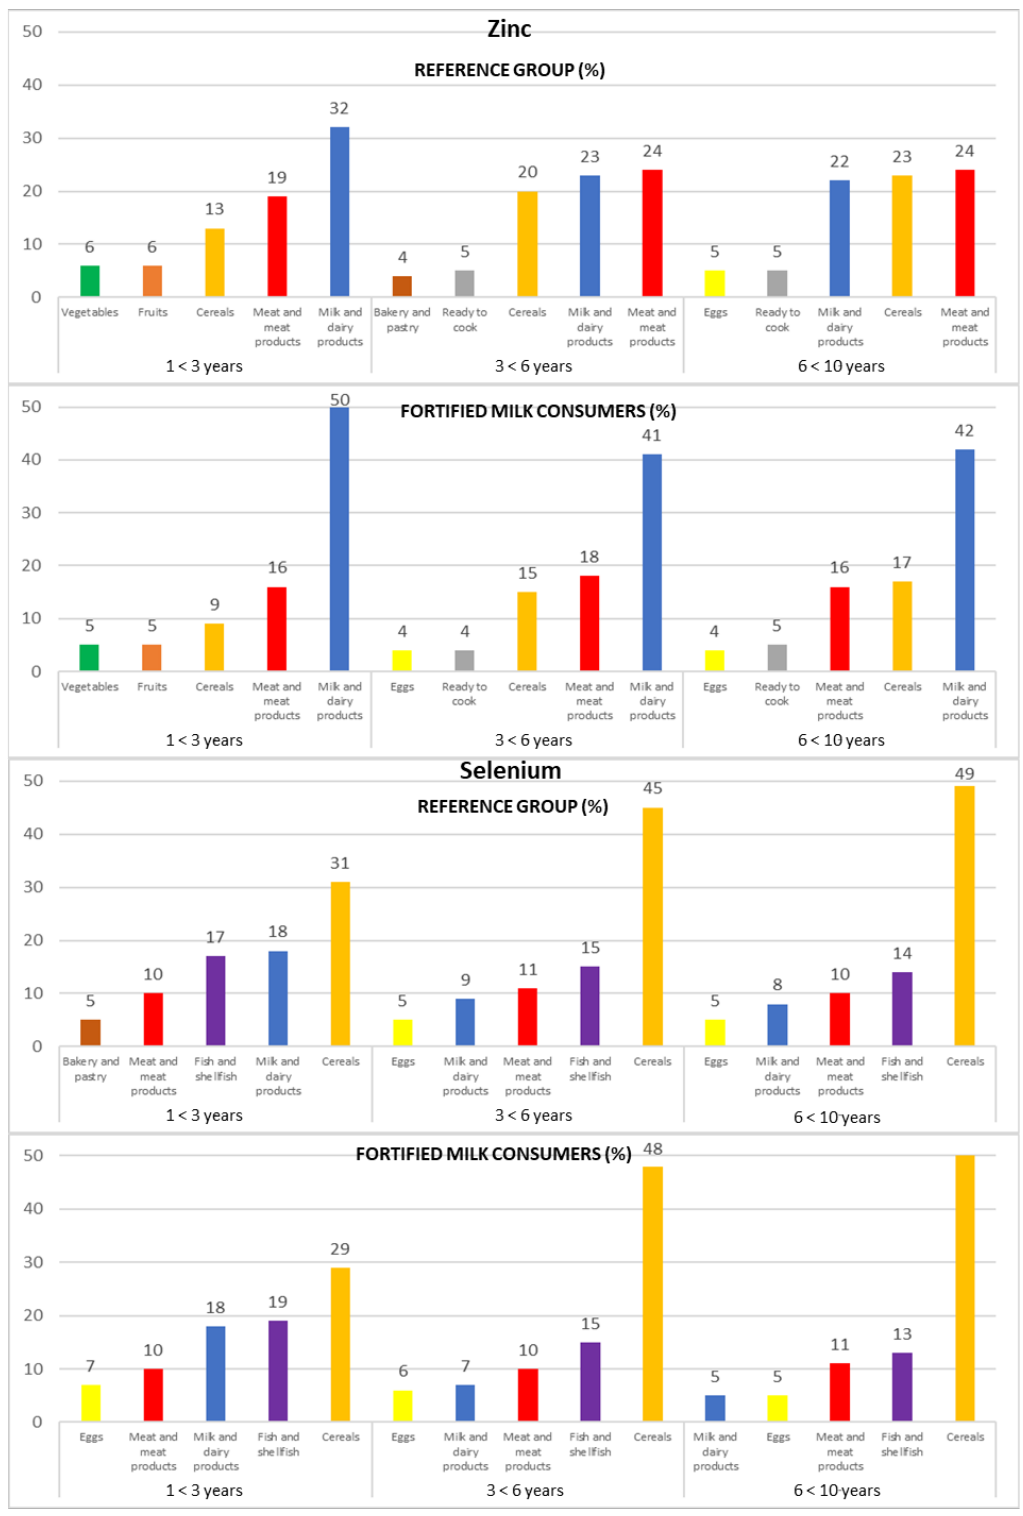
Figure 1. Contribution of the main five food groups (in percentages) to total zinc and selenium intakes in the EsNuPI study subpopulations according to age group: 1 to <3 years, 3 to <6 years, and 6 to <10 years.